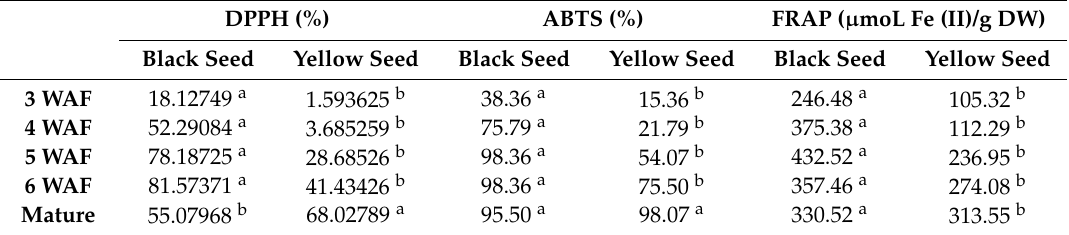
Table 1. Antioxidant activities of black and yellow seeds determined by DPPH, ABTS and FRAP assays. DPPH (%) ABTS (%) FRAP ( µ moL Fe (II)/g DW) Black Seed Yellow Seed Black Seed Yellow Seed Black Seed Yellow